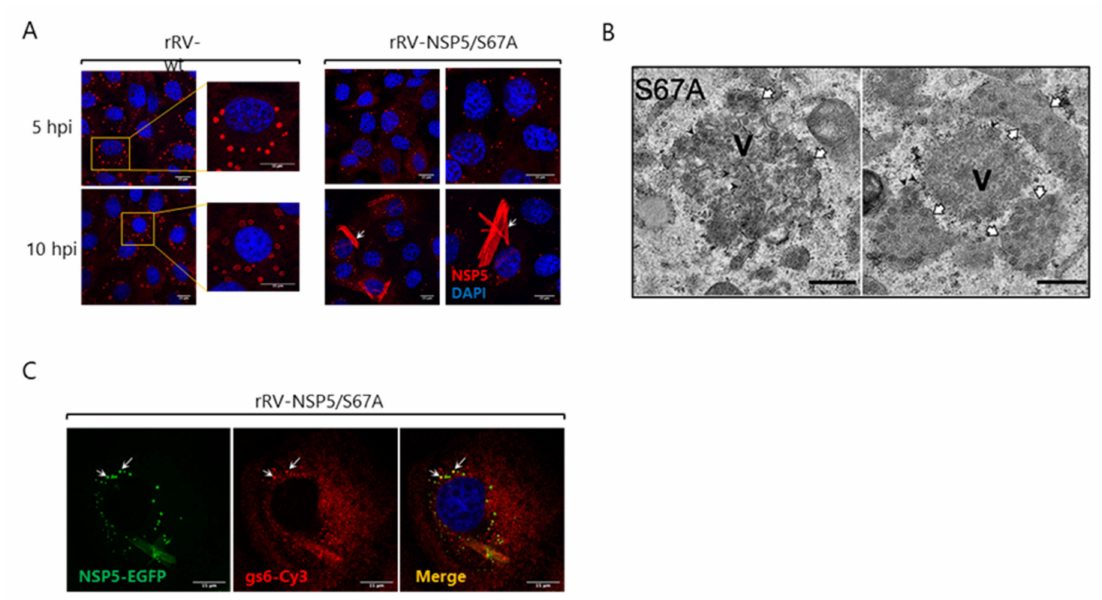
Figure 3. Replication of rRV-NSP5/S67A mutant: Pivotal role of phosphorylation in assembling round-shaped and fully functional viroplasms. ( A ) Immunofluorescent images of MA104 cells infected with rRV-wt and rRV-NSP5/S67A (MOI of 15 FFU/cell) at 5 hpi (upper panels) or 10 hpi (lower panels). Cells were stained with anti-NSP5 (red) and DAPI (blue). Scale bar, 15 µ m. From Papa et al. [25]; ( B ) Electron microscopy image of MA104 cells infected with rRV-NSP5/S67A (MOI, 75 FFU/cell) at 10 hpi. V, viroplasm. White arrows indicate the endoplasmic reticulum surrounding viroplasms; black arrowheads indicate putative viral particles with an envelope. Scale bar, 500 nm. From Papa et al. [25]; ( C ) RNA Fluorescence In Situ Hybridisation (RNA-FISH) on MA104-NSP5-EGFP cells infected with rRV-NSP5/S67A. Viroplasms detected with NSP5-EGFP (green) and viral RNA (probe specific for genome segment 6-specific probe was with Cy3 (red). Co-localization of viroplasms and RNA is indicated by white arrows. Scale bar, 15 µ m. From Papa et al.